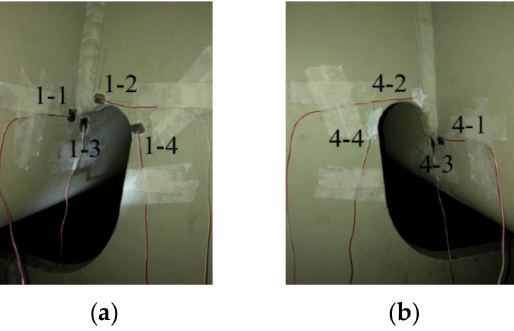
Figure 4. Strain gauges applied on real bridge. ( a ) West side of R13; ( b ) East side of R11.